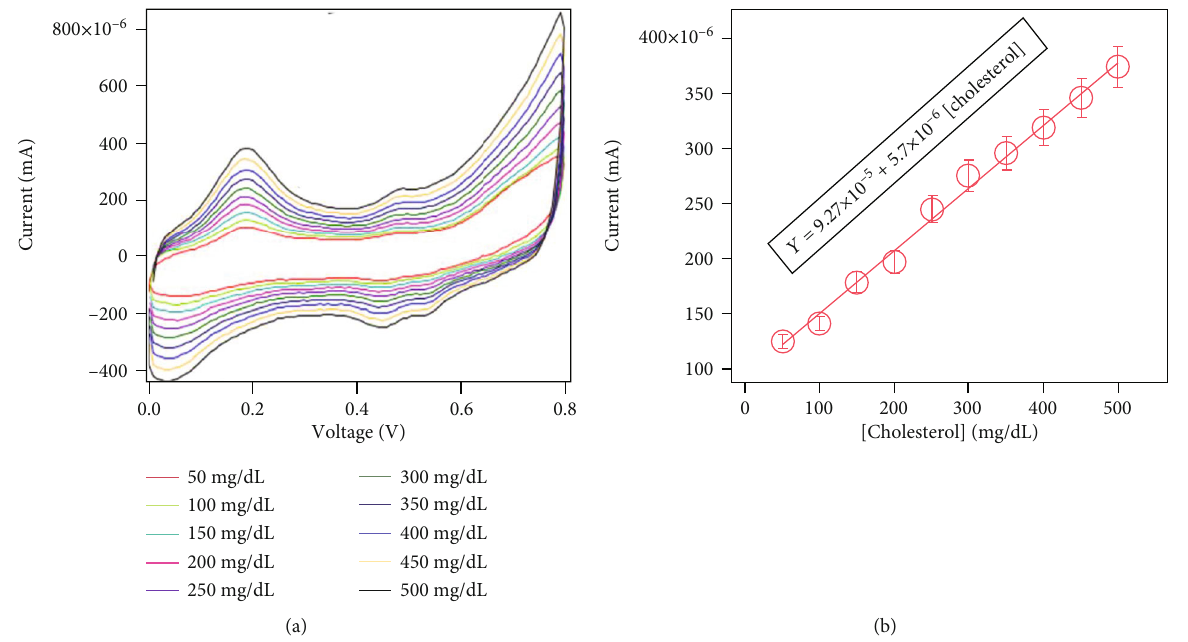
Figure 5: (a) CV with varying cholesterol concentrations from 50 to 500mg/dL on ChOx/CeO containing Fe(CN) 63 − /4 − and (b) electrode response as a function of cholesterol